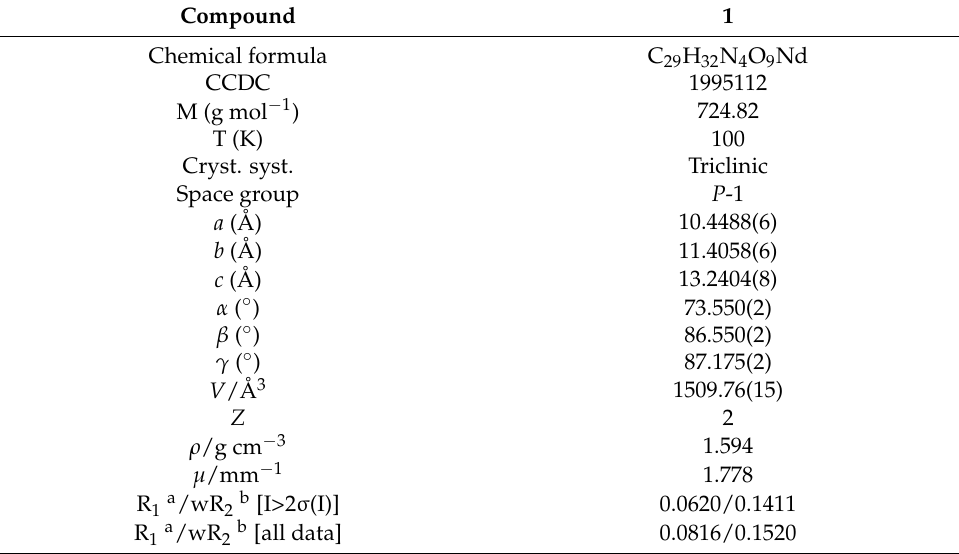
Table 2. Crystallographic data and structure refinement details of compound 1 .